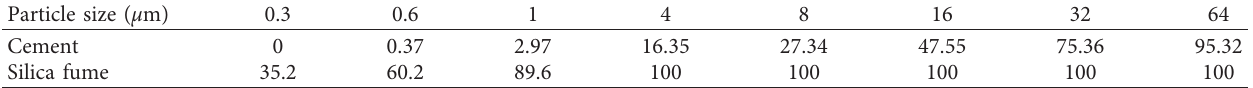
Table 7: Cumulative pass rate of fine aggregate